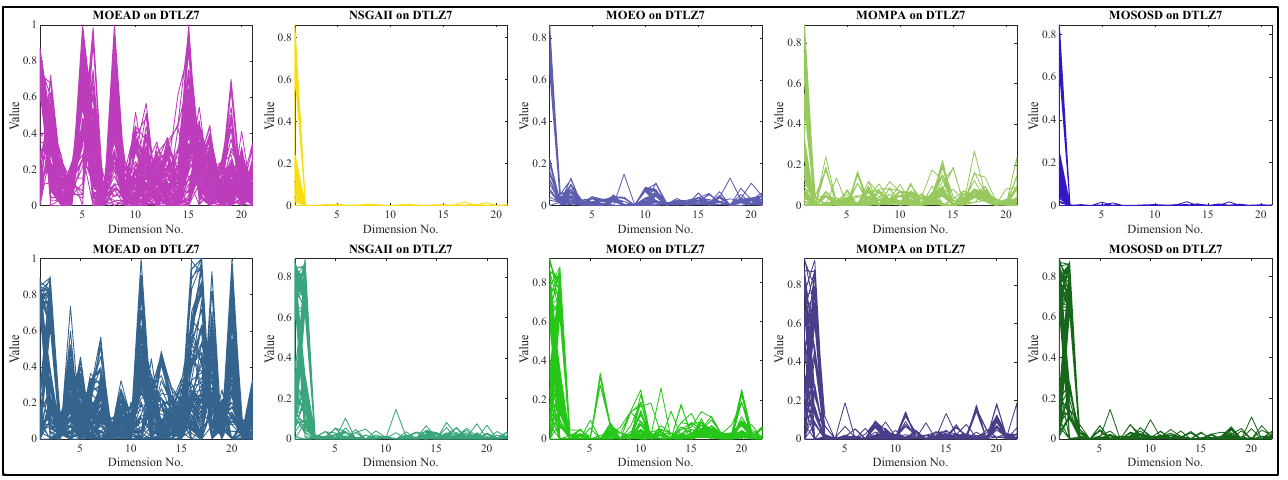
Figure 15. The dimension curve of MOEA/D, NSGA-II, MOEO, MOMPA, and MOSOS/D for DTLZ7 at 𝑀 = 2, 3 .